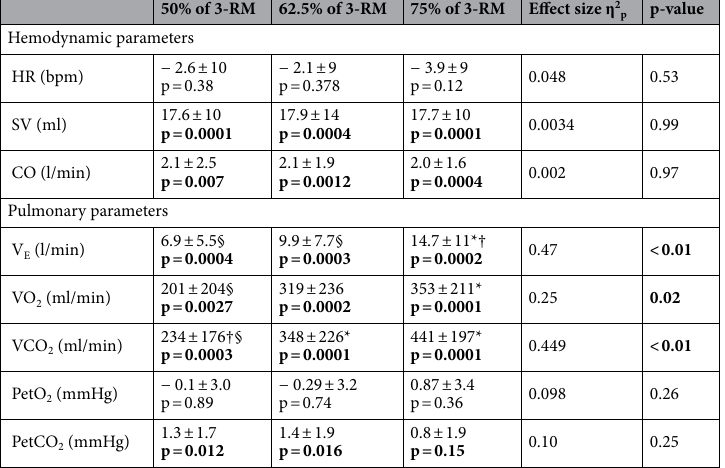
Table 5. Change in parameters from exercise period (three sets of 10 repetitions) to post-exercise period (one minute after exercise). Significant values are in bold. Values are presented the difference between post-exercise period and exercise period as the means and standard deviation. The p value in cells represents the comparison between exercise and post-exercise period. 3‑RM three repetition maximum, HR heart rate, SV stroke volume, CO cardiac output, V E ventilation, VO 2 oxygen uptake, VCO 2 carbon dioxide output, PetO 2 end-tidal oxygen partial pressure, PetCO 2 end-tidal carbon dioxide partial pressure; * (P < 0.05) different from 50% intensity; † (P < 0.05) different from 62.5% intensity; § (P < 0.05) different from 75%